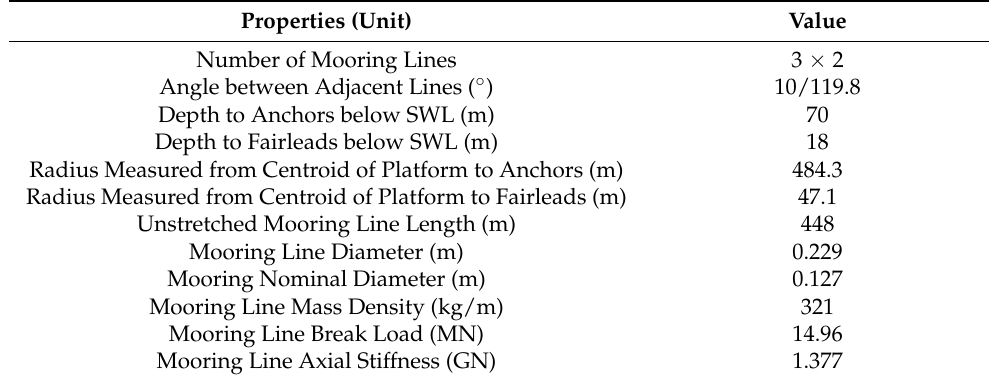
Table 2. Specifications of mooring lines.